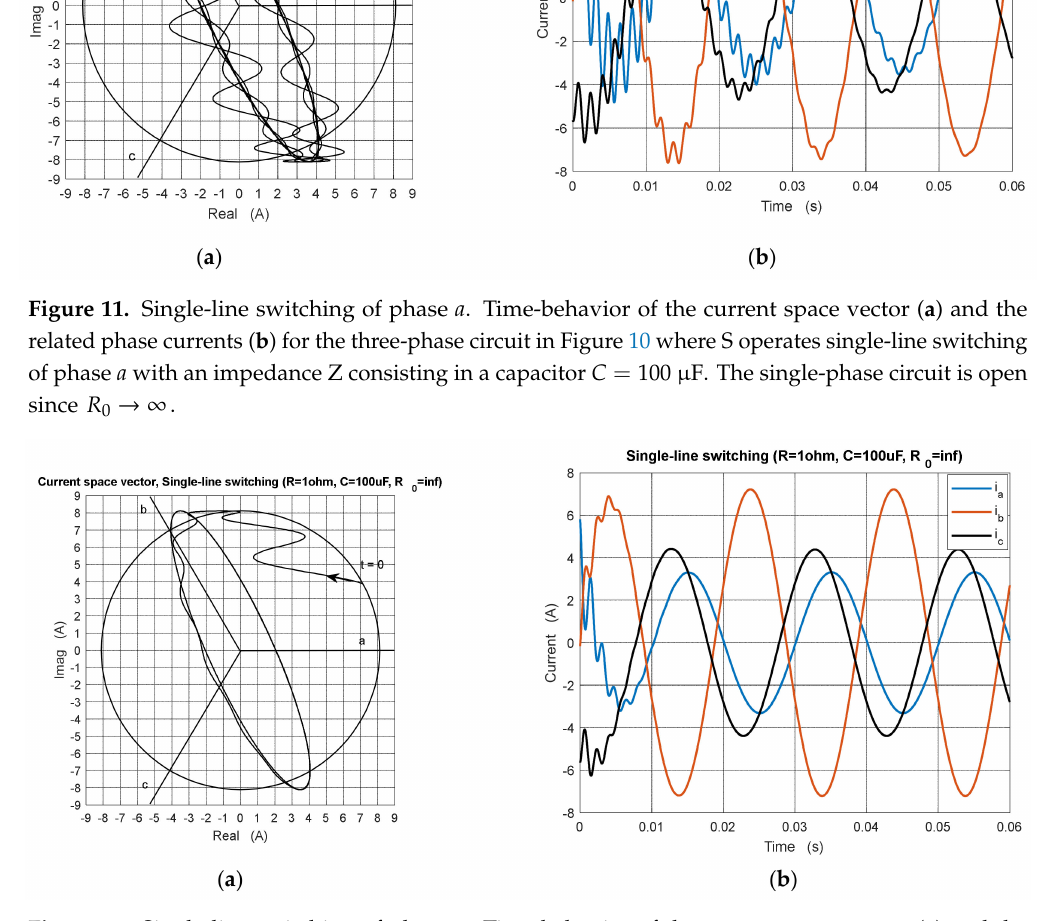
Figure 12. Single-line switching of phase a . Time-behavior of the current space vector ( a ) and the related phase currents ( b ) for the three-phase circuit in Figure 10 where S operates single-line switching of phase a with an impedance Z consisting of a capacitor C = 100 µ F in series with a resistor R = 1 Ω . The single-phase circuit is open since R 0 → ∞